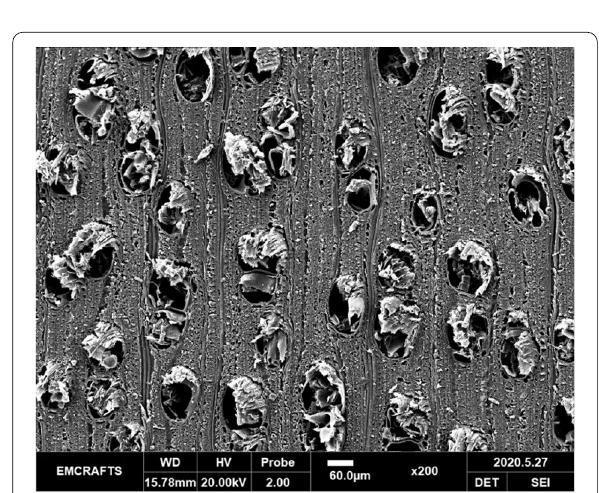
Fig. 5 SEM image of the cross‑sectional surface of ultrasound‑treated